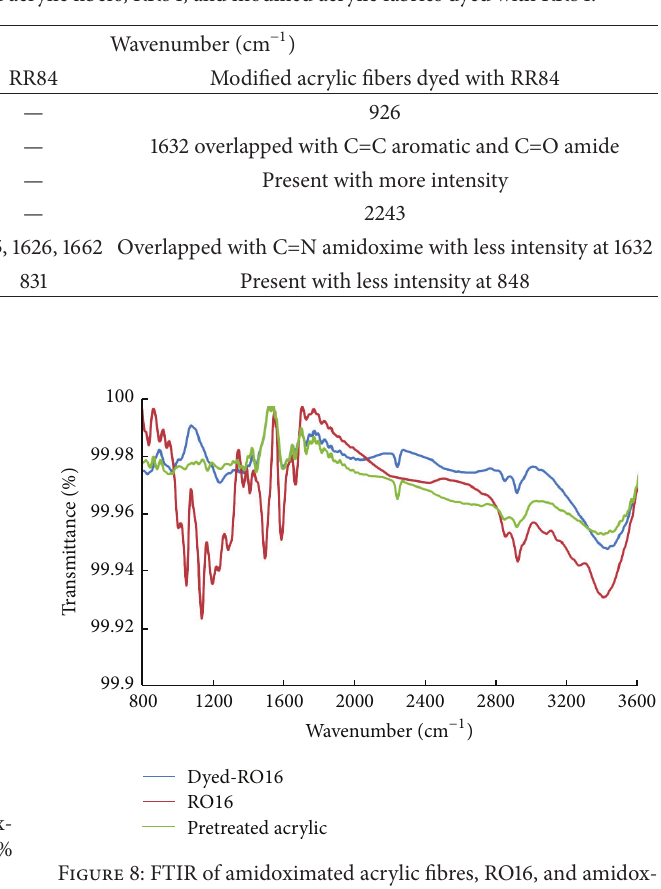
Table 4: FT-IR characteristic absorption peaks of modified acrylic fibers, RR84, and modified acrylic fabrics dyed with RR84.